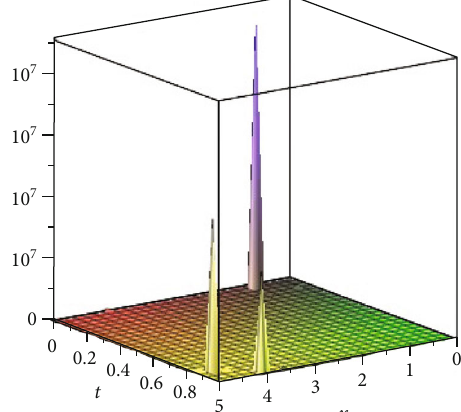
ð x , 0, 0, t Þ of Equation (69). Figure 16: u 1,3